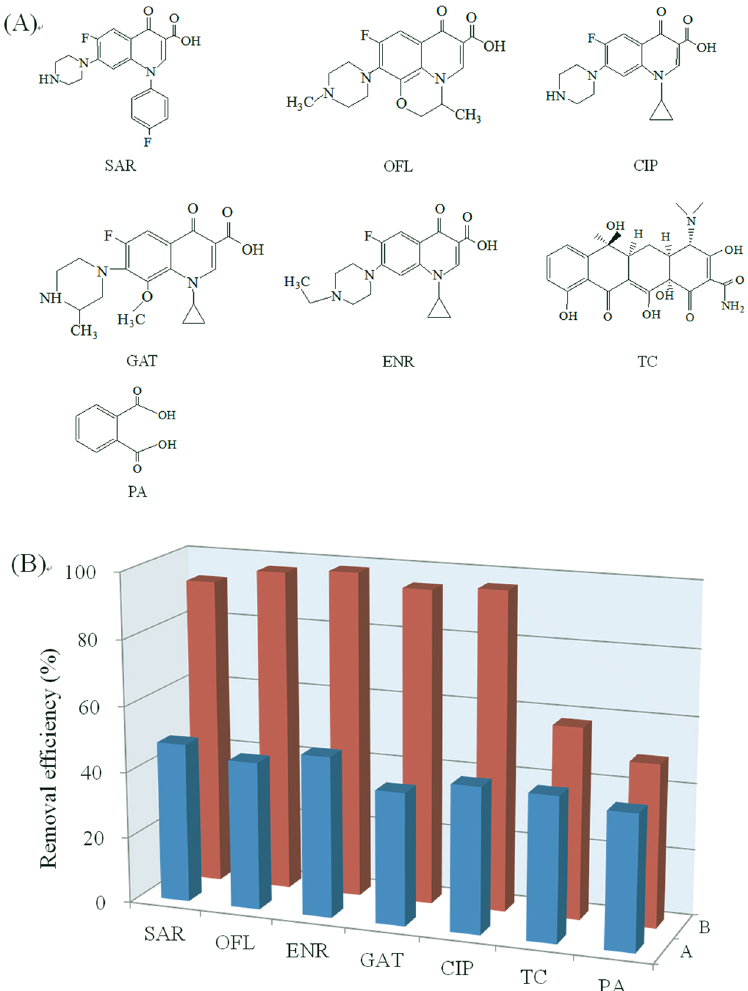
Figure 5. ( A ) Molecular structure of five FQs (SAR, OFL, CIP, GAT, EBR), TC, and PA. ( B ) removal efficiencies of the